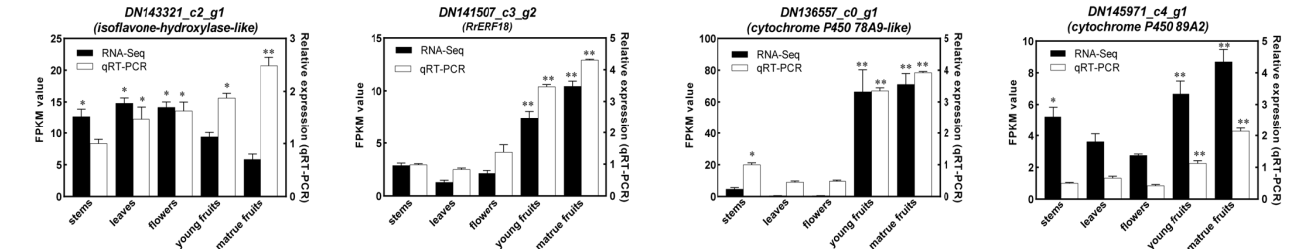
Figure 7. Comparison of expression profiles of nine hub genes from module “black” as measured by RNA-seq and qRT-PCR. Columns represent expression determined by RNA-seq in FPKM values (left y-axis), while lines represent expression by qRT-PCR (right y-axis). The x-axis in each chart represents the five organs. Both for RNA-seq and qRT-PCR assay, all data are presented as means ± SD and analyzed using one-way ANOVA followed by Turkey’s test. Asterisks represent different levels of significance (* indicates the p values ≤ 0.05, ** indicates the p value ≤ 0.01).